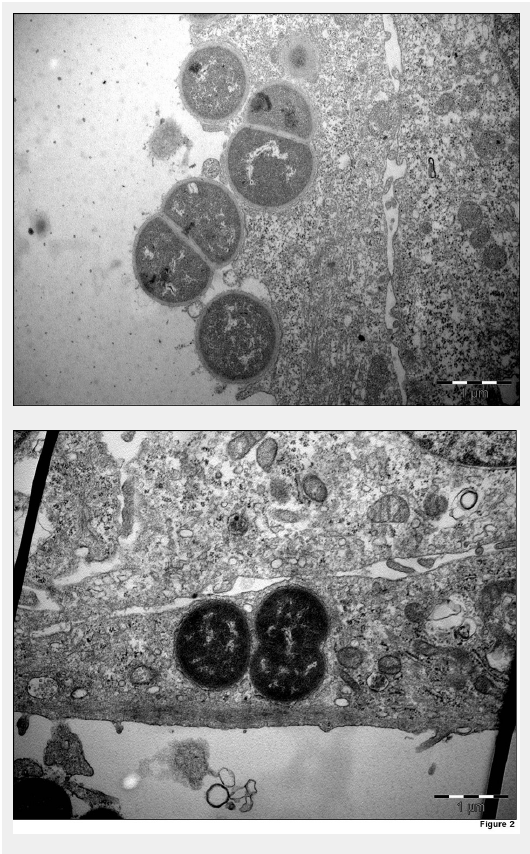
Transmission electron micrographs, demonstrating M. catarrhalis (strain 287) invasion in Detroit 526 pharyngeal